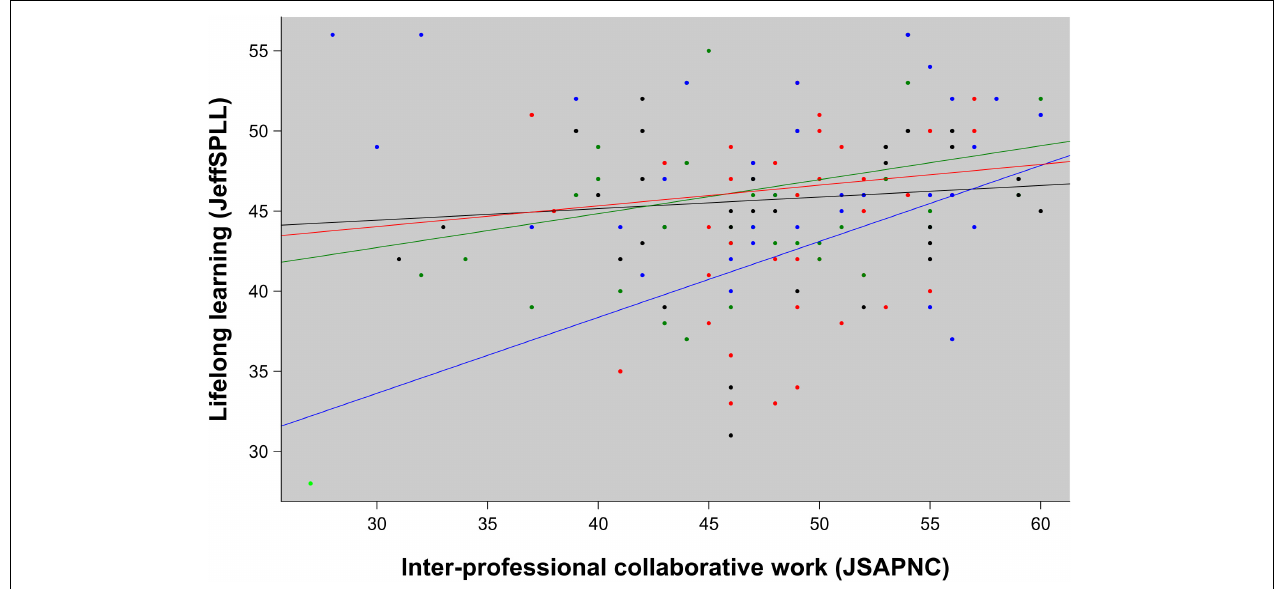
FIGURE 2 | Regression analysis of lifelong learning abilities (measured by the JeffSPLL), according to inter-professional collaborative work (measured by the JSAPNC). For “study group by degree coursework” groups: in red, medical students in the experimental group; in blue, nursing students of the experimental group; in green, medical students of the control group; and in black, nursing students of the control group ( p = 0.028).